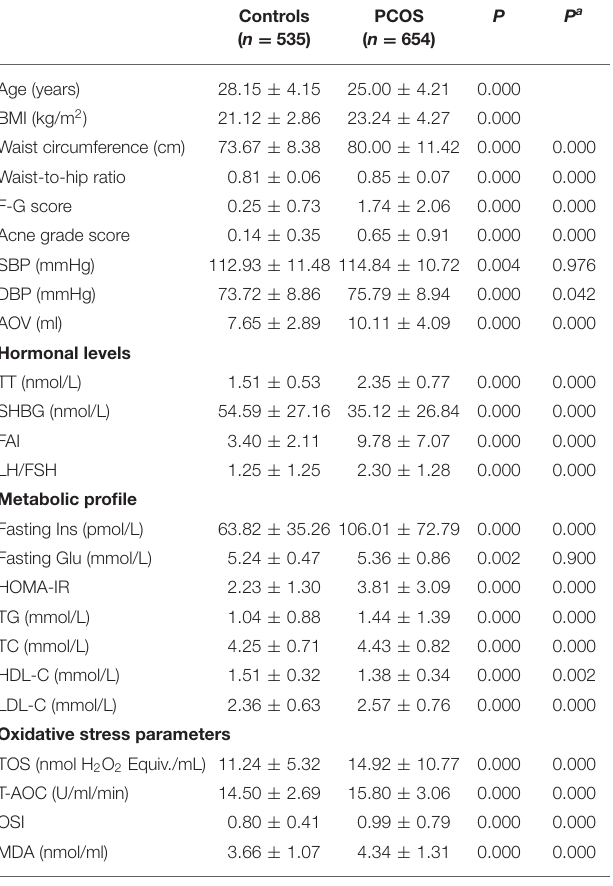
TABLE 2 | Frequencies of GPx P198L (Pro198Leu) and CAT C-262T genotype TABLE 1 | Clinical, hormonal, metabolic, and oxidative stress parameters in and allele in PCOS patients compared with control women. PCOS patients and control women. P P a Controls PCOS Controls PCOS x 2 ( n = 535) ( n = 654)